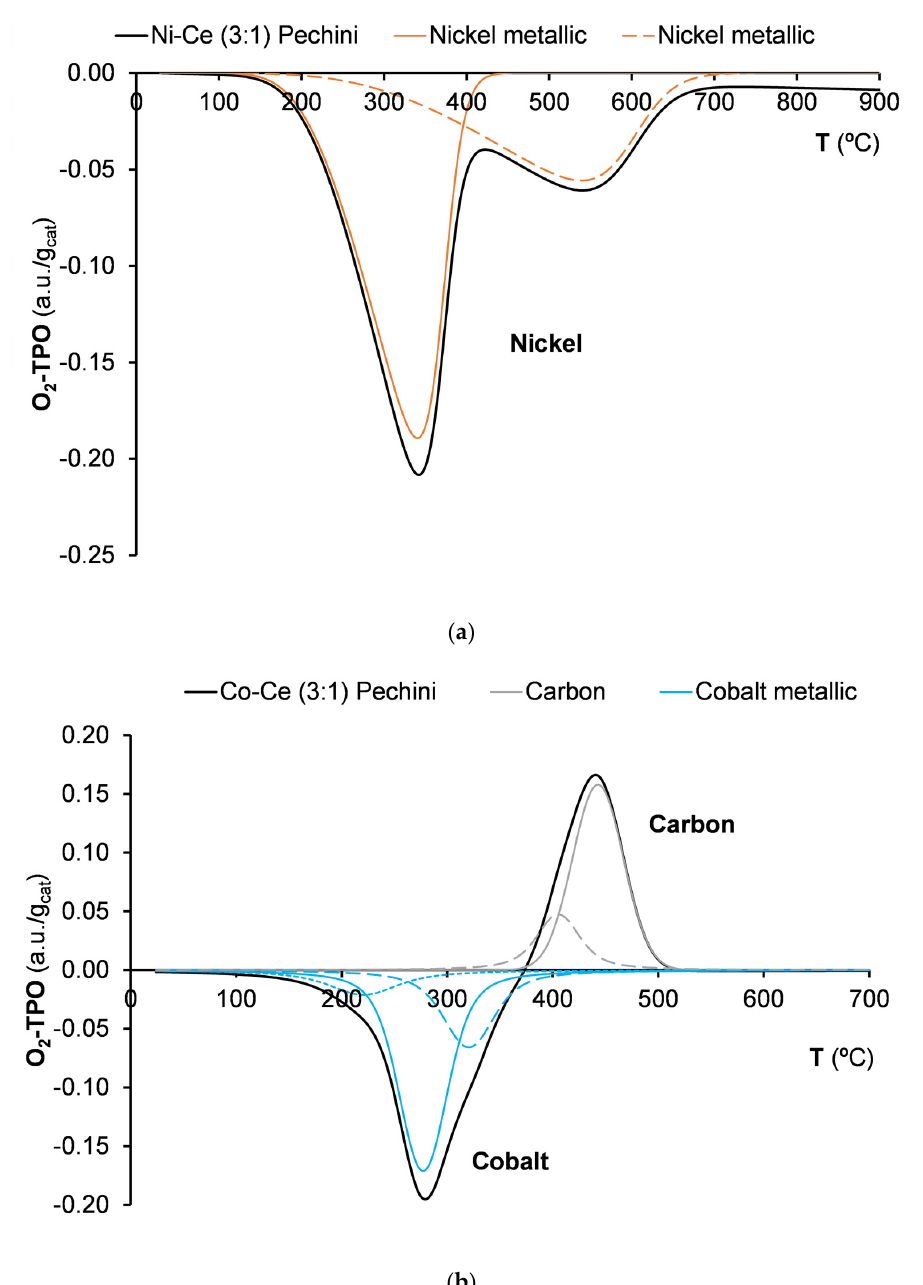
Figure 8. O 2 -TPO profiles obtained after reaction for ( a ) nickel–cerium and ( b ) cobalt–cerium bimetal- lic oxides catalysts pre-treated under hydrogen and prepared by the Pechini